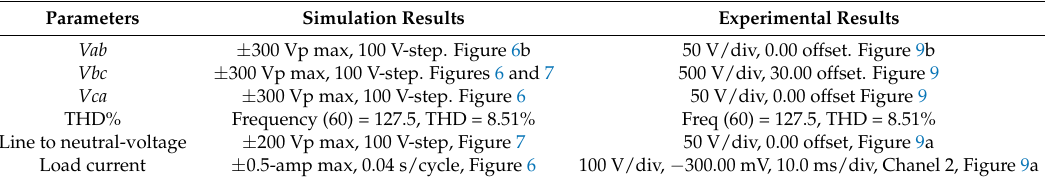
Table 8. Direct comparison between the outcome values of parameters in simulation and